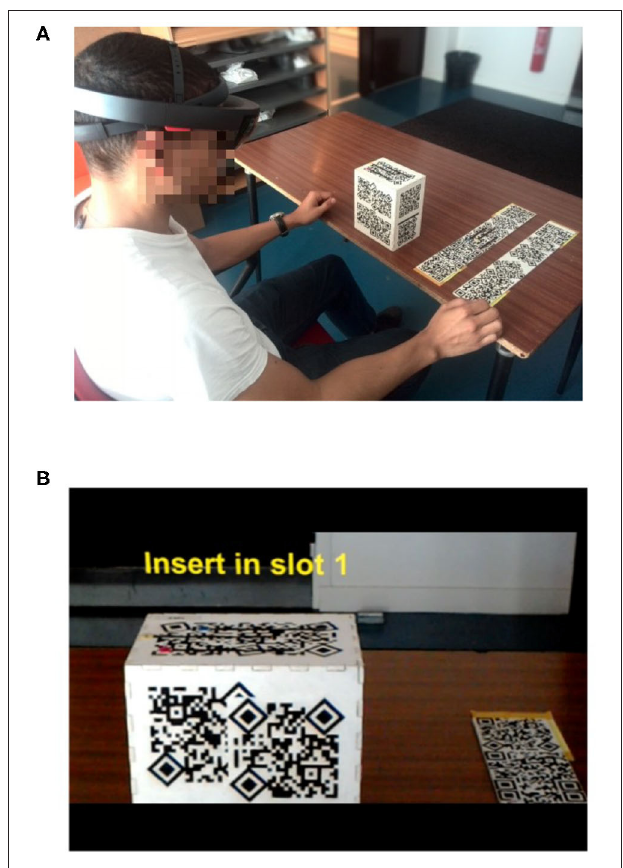
FIGURE 3 | (A) A participant before starting the task. (B) The First-Person View (FPV) on the HoloLens (captured from the Mixed Reality Viewer) displaying textual instruction before starting operation 1.